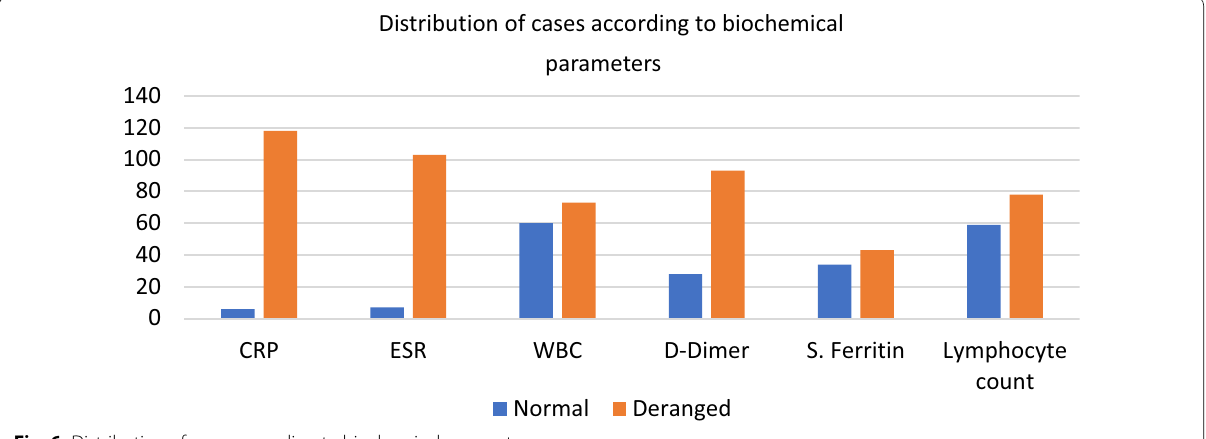
Fig. 6 Distribution of cases according to biochemical parameters